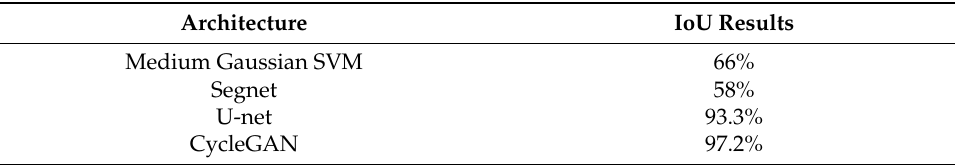
Table 2. IoU results using different architectures.